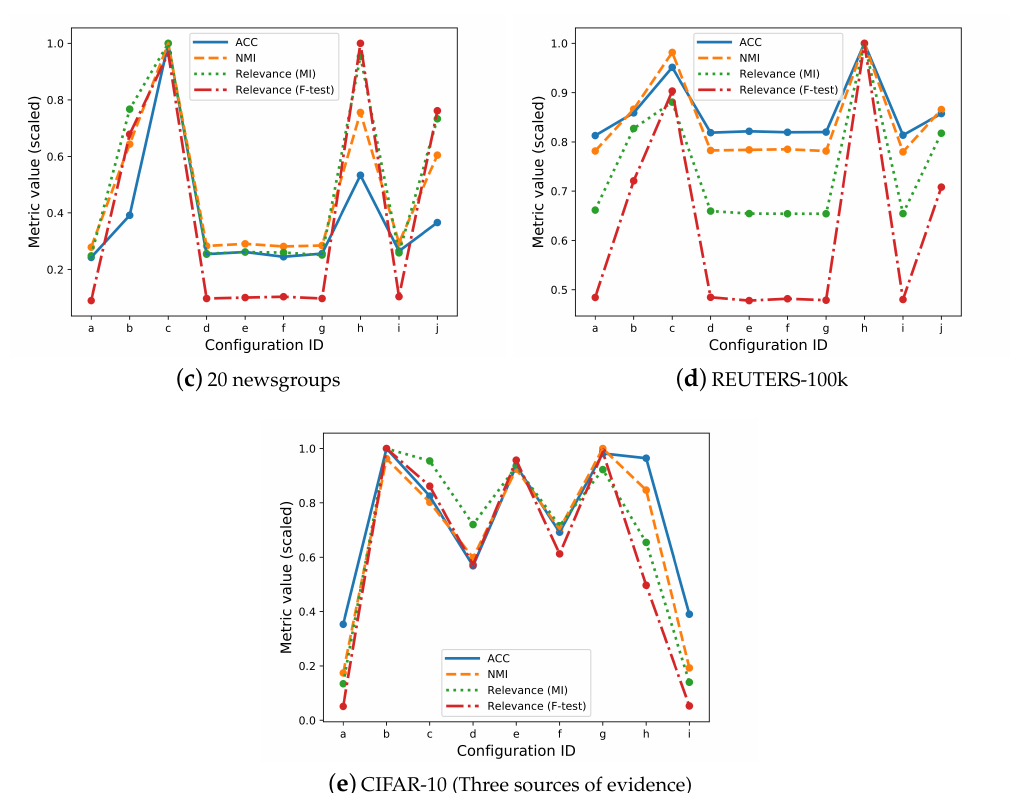
Figure 1. A comparison of the Relevance metric from feature selection with Unsupervised Accuracy (ACC) and Normalised Mutual Information used for clustering prediction evaluation: We compare both approaches of Relevance (Mutual Information and F-test). To interpret the effects of evidence transfer, we analyse the behaviour of these metrics in five different scenarios. Each subfigure represents a single scenario, and the comparison of the metrics is performed individually on each